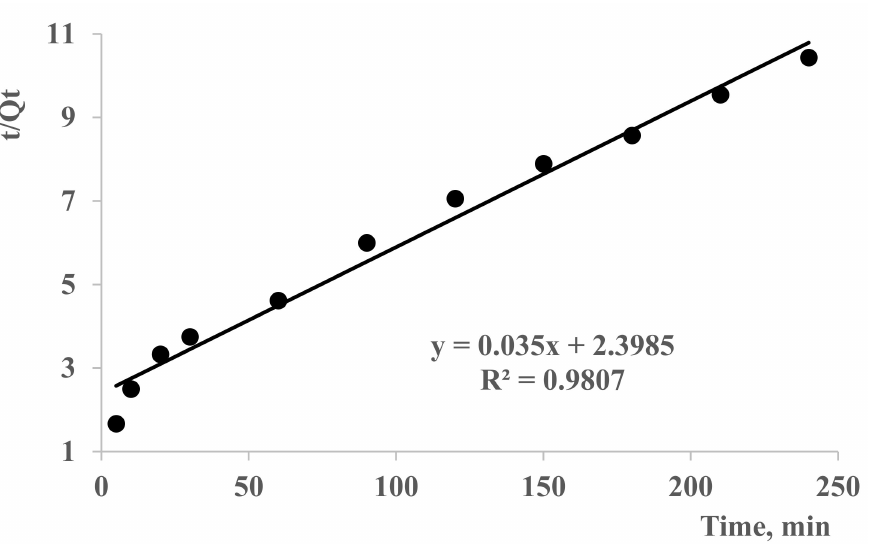
Figure 8. Pseudo-first-order models isotherms for Pb(II) removal by DMAA–AMPS hydrogel. Condi- tions: mass of dry hydrogel 100 mg; concentration solution of 30 mg/L and 25 ◦ C. Hydrogel (50–50% DMAA–AMPS molar ratio, initiator concentration 0.07% of total monomer mass, 0.74% crosslinker, total monomer concentration 5 M) was